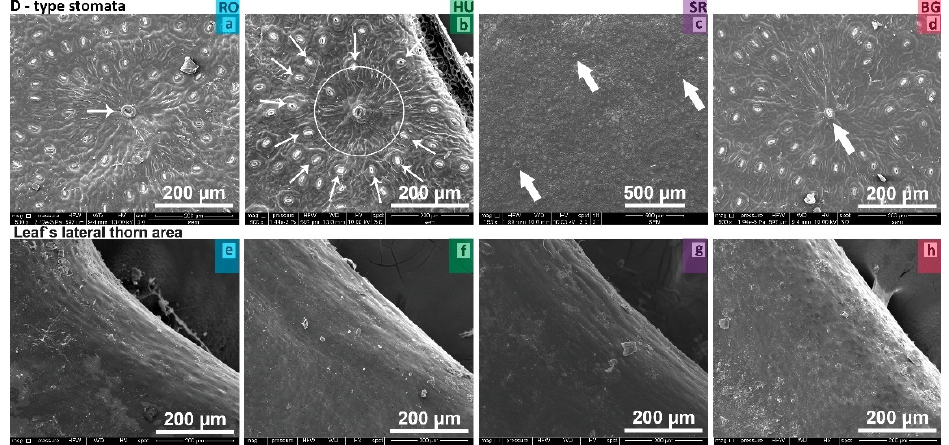
Figure 4. SEM assessment of the morphological aspects: D-type stomata and lateral leaf thorn surface ( e – h ). Giant/D-type stomata apparatuses (( a , c , d ), thin/thick arrows) and peripheral stomata (( b ), thin arrows) with radial orientations.